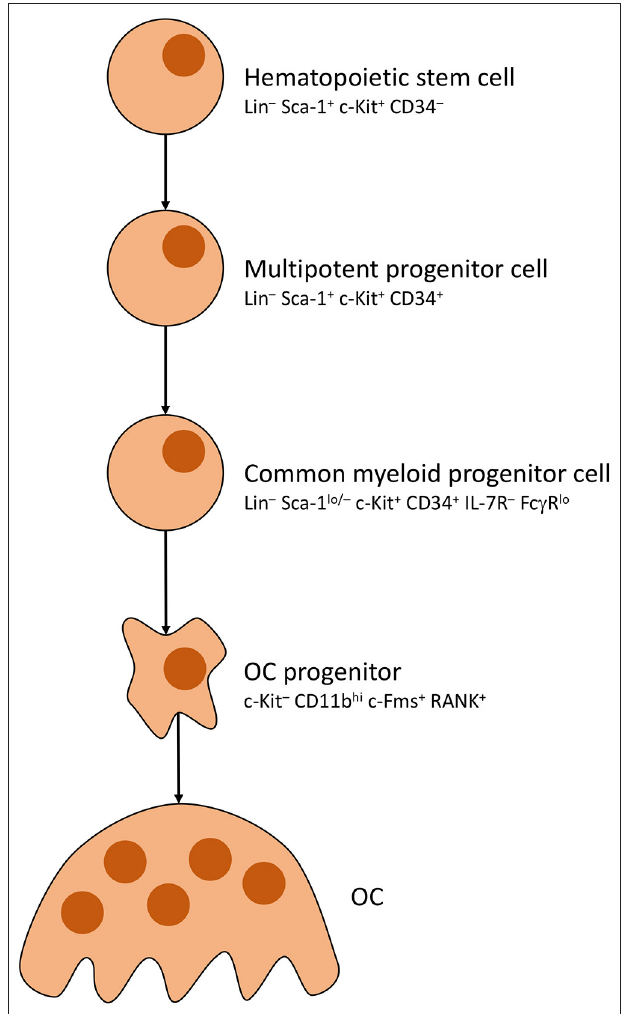
FIGURE 2 | Osteoclast development. Simplified presentation of OC development. Other than OBs, OCs develop from hematopoietic stem cells. Stem cells lose self-renewing potential during development. Other blood cells branch off from multipotent progenitor cells. OC progenitor cells iterate to become RANK + , then fuse into OCs with multiple